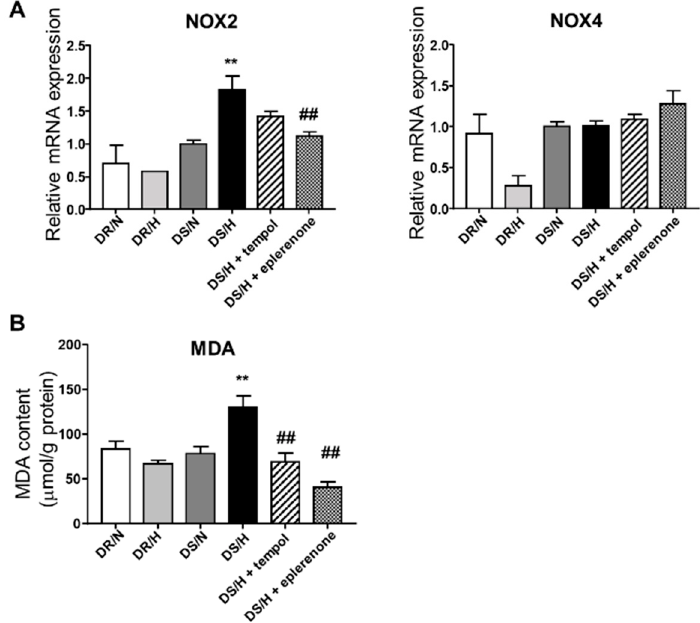
Figure 4. Evaluation of oxidative stress. Analysis of the renal gene expression of Nox2 and Nox4 ( A ) and MDA content ( B ). MDA, malondialdehyde. Values are presented as means ± SE ( n = 6). **, p < 0.01 vs. DS/N rats. ## , p < 0.01 vs. DS/H rats.